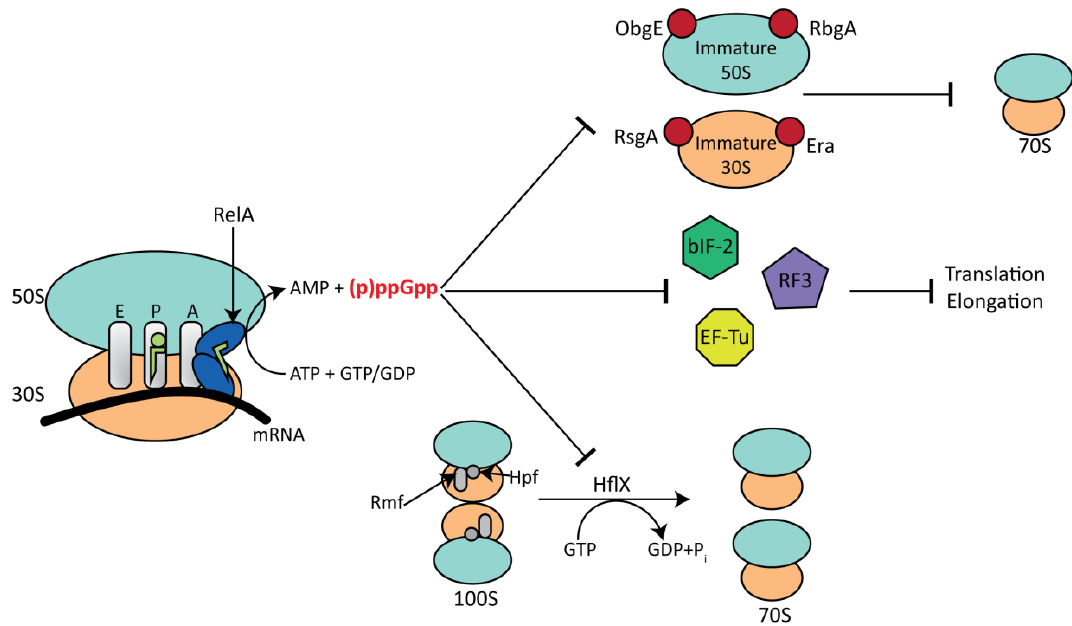
Figure 4. The effect of the stringent response on ribosome maturation and translation. During the stringent response the alarmones (p)ppGpp accumulate following synthesis by RSH-superfamily enzymes. In E. coli, the interaction between RelA (dark blue) with the ribosome activating complex (RAC) increases the synthesis of (p)ppGpp. The RAC consists of the ribosome (50S, lightblue; 30S, orange), mRNA and uncharged tRNA (green). A charged tRNA is situated in the P site of the ribosome. (p)ppGpp inhibits the GTPase activity of various small GTPases, preventing correct ribosome maturation. (p)ppGpp also inhibits the splitting of inactive 100S ribosome dimers by HflX but promotes splitting of 70S ribosomes to inactive 50S and 30S subunits. Furthermore, (p)ppGpp inhibits the translational GTPase bIF-2, EF-Tu and RF3, resulting in a reduction in